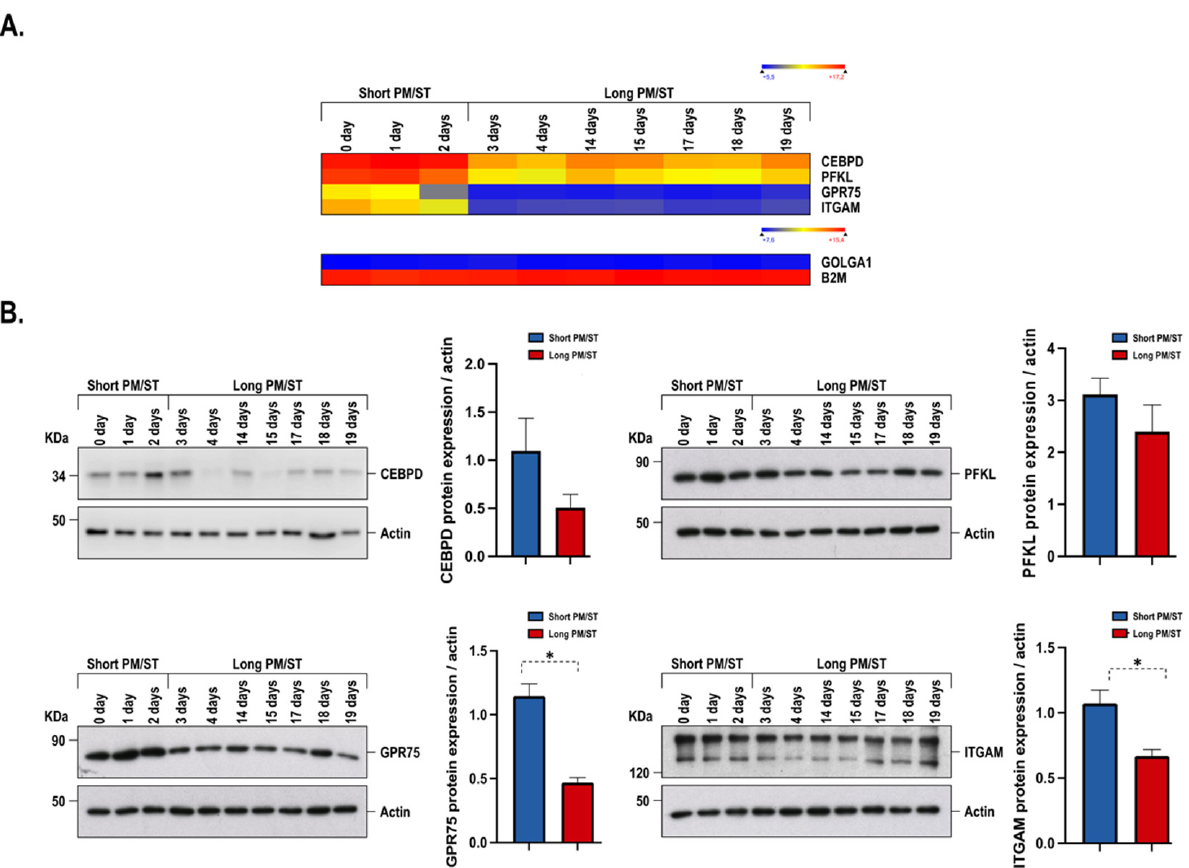
Figure 2. Gene expression profile and Western blot analysis of four out of the 50 most differentially regulated genes ( CEBPD , PFKL , GPR75 , and ITGAM ) in all hLECs populations. Actin was used as the loading control. Graphs show the differences in CEBPD, PFKL, GPR75, and ITGAM expression between SPM/ST hLECs and LPM/ST hLECs. p -value: * < 0.08.